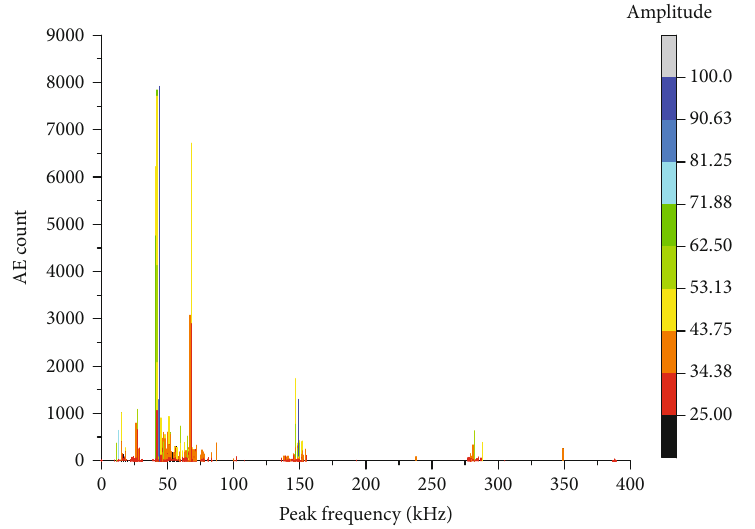
Figure 8: Distribution of AE count with peak frequency. The acoustic emission count of range near 388kHz was very